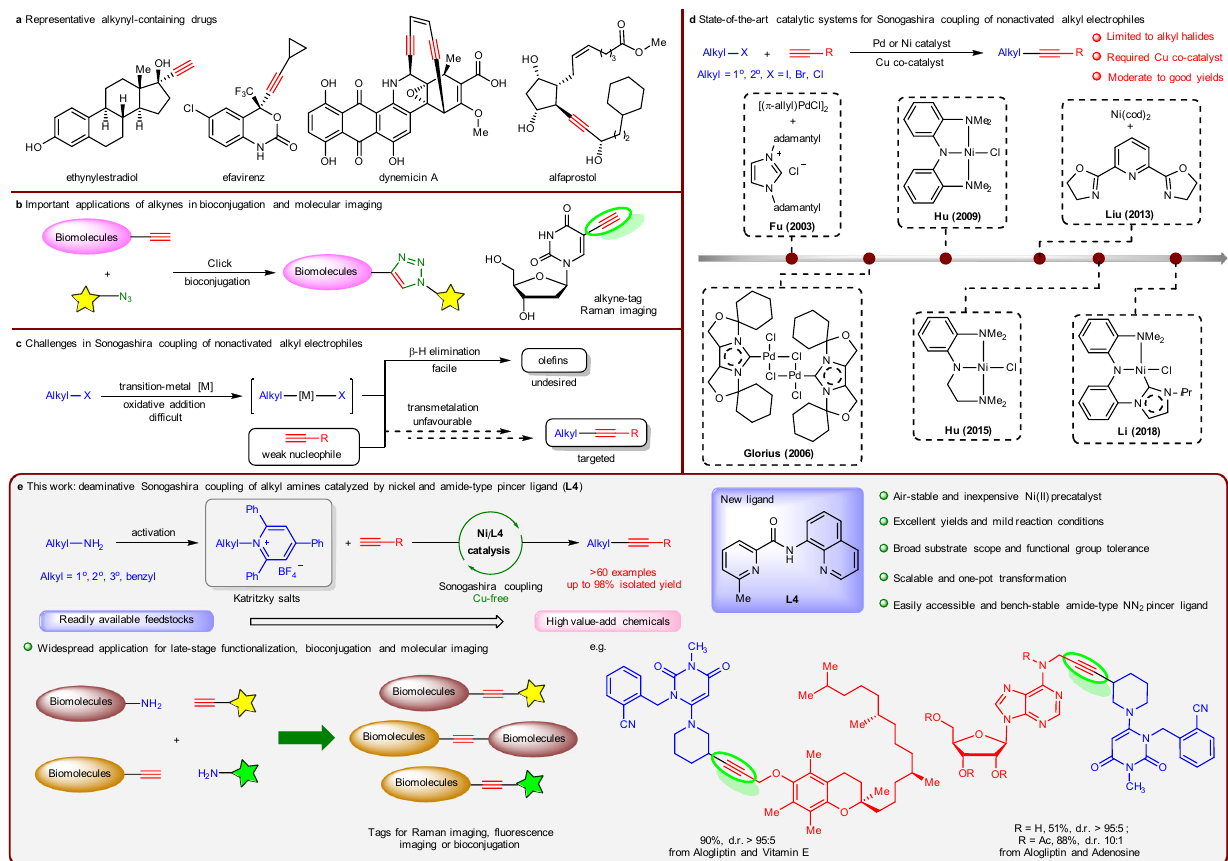
Fig. 1 Signi fi cances and strategies for Sonogashira coupling of nonactivated alkyl electrophiles. a Representative alkynyl-containing drugs (ethynylestradiol, hormone drug for estrogen medication; efavirenz, an antiretroviral drug for HIV/AIDS; dynemicin A, an antitumor drug for cancer treatments; alfaprostol, a veterinary drug for breeding control). b Important applications of alkynes in bioconjugation and molecular imaging. c Challenges in Sonogashira coupling of nonactivated alkyl electrophiles. d State-of-the-art catalytic systems for Sonogashira coupling of nonactivated alkyl electrophiles. e This work: deaminative Sonogashira coupling of alkyl amines catalyzed by nickel and amide-type pincer ligand ( L4